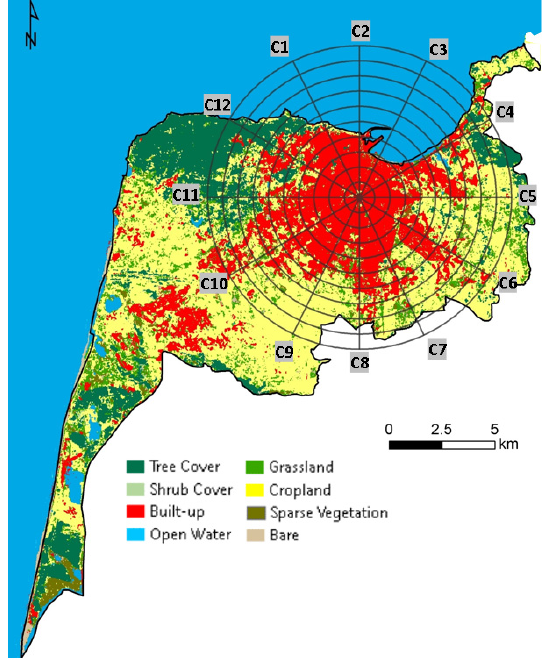
Figure 3. Land cover classification for the urban area of Tangier (buffers shown every 720 m).